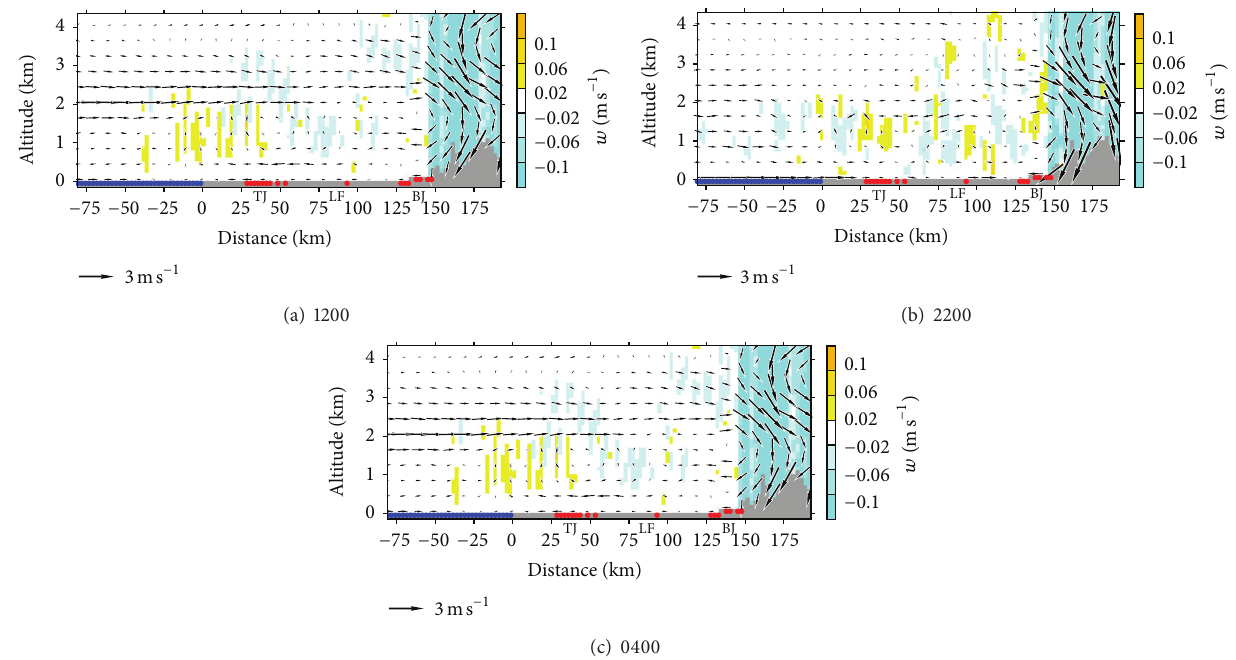
Figure 6: Vertical cross section of simulated wind field of CNTL experiment from A to B in Figure 1(b), with the reference point (0, 0) located at the border (point O in Figure 1(b)) of land and sea. (a) 1200LST 24 August, (b) 2200 LST 24 August, and (c) 0400LST 25 August. The urban land use grids are indicated by the red dots, while the water land uses grids that are presented by the blue dots. To plot the vector field, the U and 𝑤 have been multiplied by a factor of 0.5 and 10, respectively, while the real value of 𝑤 is shown by the color shade background. The three cities from left to right are Tianjin (TJ), Langfang (LF), and Beijing (BJ), respectively.